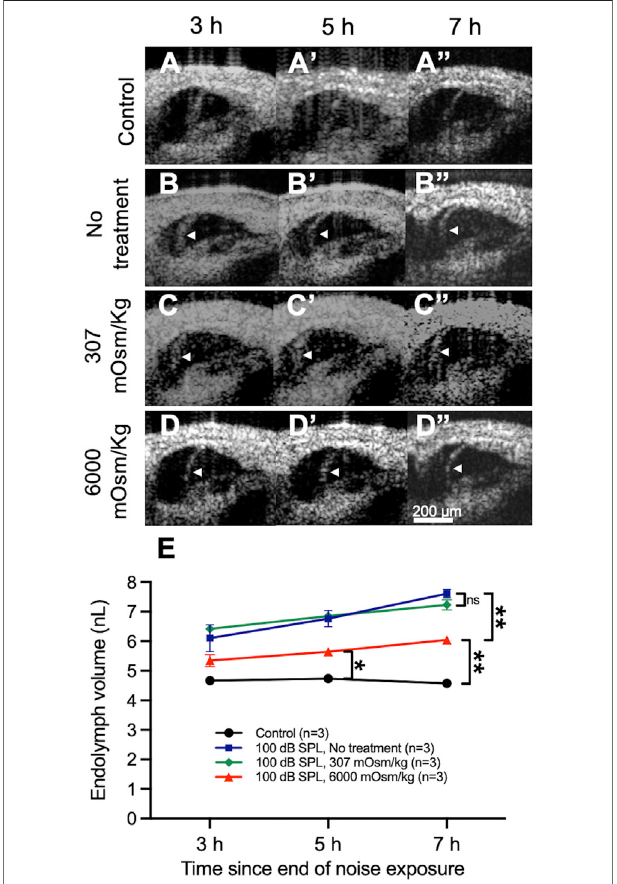
FIGURE 5 | Osmotic treatment partially reduces the degree of endolymphatic hydrops that develops after 2 h of 100 decibel (dB) sound pressure level (SPL) noise exposure. (A) Controlmice that were not exposed to noise had no change in endolymph volume over time and demonstrated no bowing of Reissner ’ s membrane (RM). (B) Noise-exposed mice without round window solution application (no treatment) developed posttraumatic endolymphatic hydrops with outward bowing of RM. White arrow heads indicate the bowed position of RM. (C) Round window application of normotonic saline (307 mOsm/kg) had no impact on endolymphatic hydrops. (D) Noise-exposed mice treated with hypertonic saline (6,000 mOsm/kg) showed a reduction of endolymphatic hydrops with decreased bowing of RM toward the scala vestibuli when compared with noise-exposed mice that were untreated or those treated with normotonic saline. (E) Quanti fi cation of endolymph volume over time in mice exposed to 100 dB SPL noise after undergoingroundwindowapplicationofhypertonicsaline,normotonicsaline,or no treatment, as well as unexposed control mice. Endolymph volume in noise- exposed mice treated with hypertonic saline was reduced compared with untreated mice and elevated compared with unexposed control mice at 7 h following the end ofnoise exposure. Endolymph volumeinnoise-exposed mice treated with normotonic saline was not signi fi cantly different than in noise- exposed untreated mice at any time point. Endolymph volume represents the volume of the scala media over a segment of basement membrane that is 150 μ m in length. Sample sizes are expressed in number of mice. Error bars indicate standard error. ns (cid:1) not signi fi cant, * p < 0.05, ** p < 0.01.